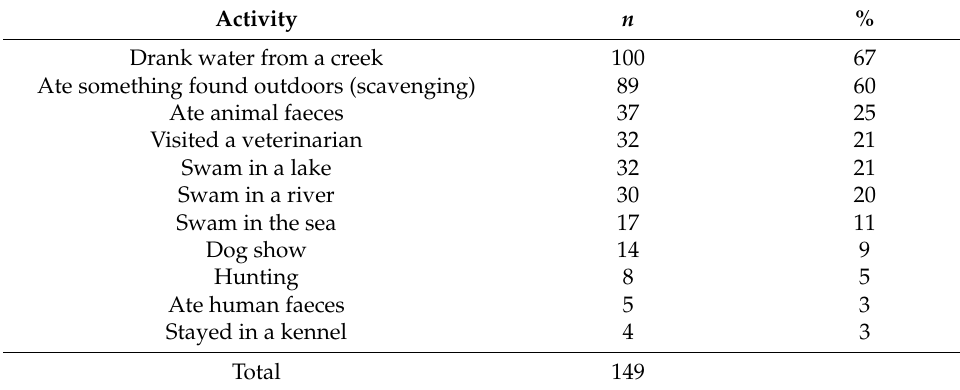
Table 4. Description of activities and places visited for case dogs the 14 days before illness onset. Online survey to veterinarians with dog patients with acute haemorrhagic diarrhoea in dogs,